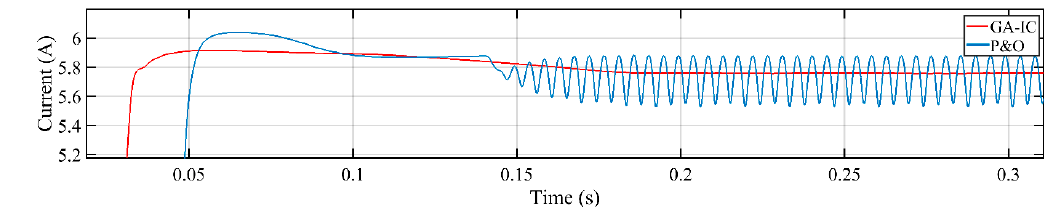
Figure 21. Case 1 current, detailed comparison of modified GA-IC vs. P&O.